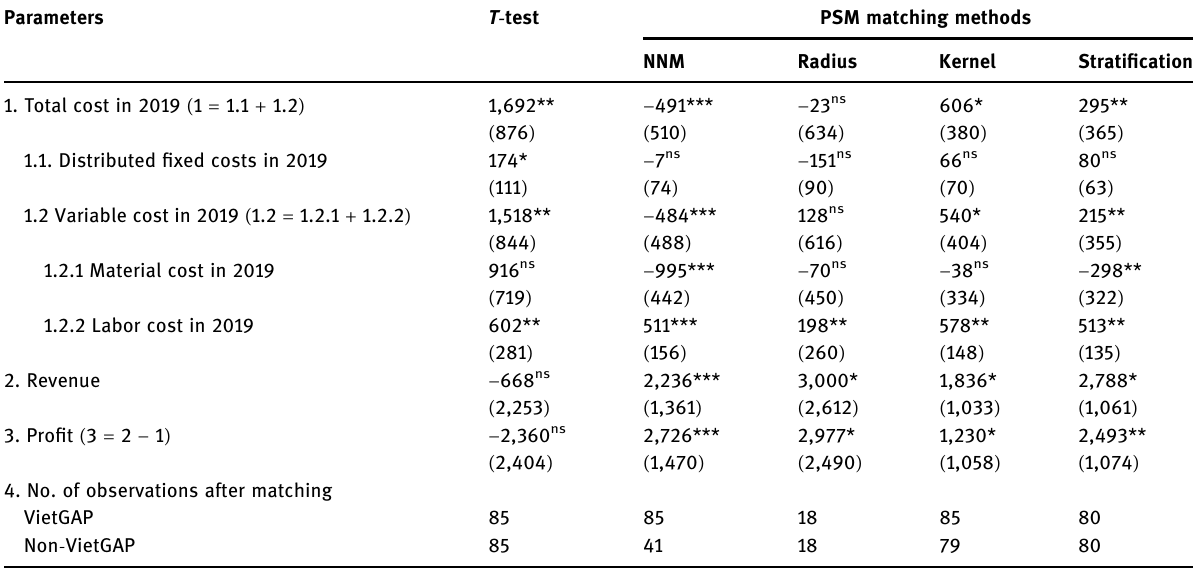
Table 5: Impacts ( VND 1,000/1,000 m 2 ) of adopting VietGAP and IPM on the income of longan growers in 2019 in the Mekong Delta, Vietnam Parameters